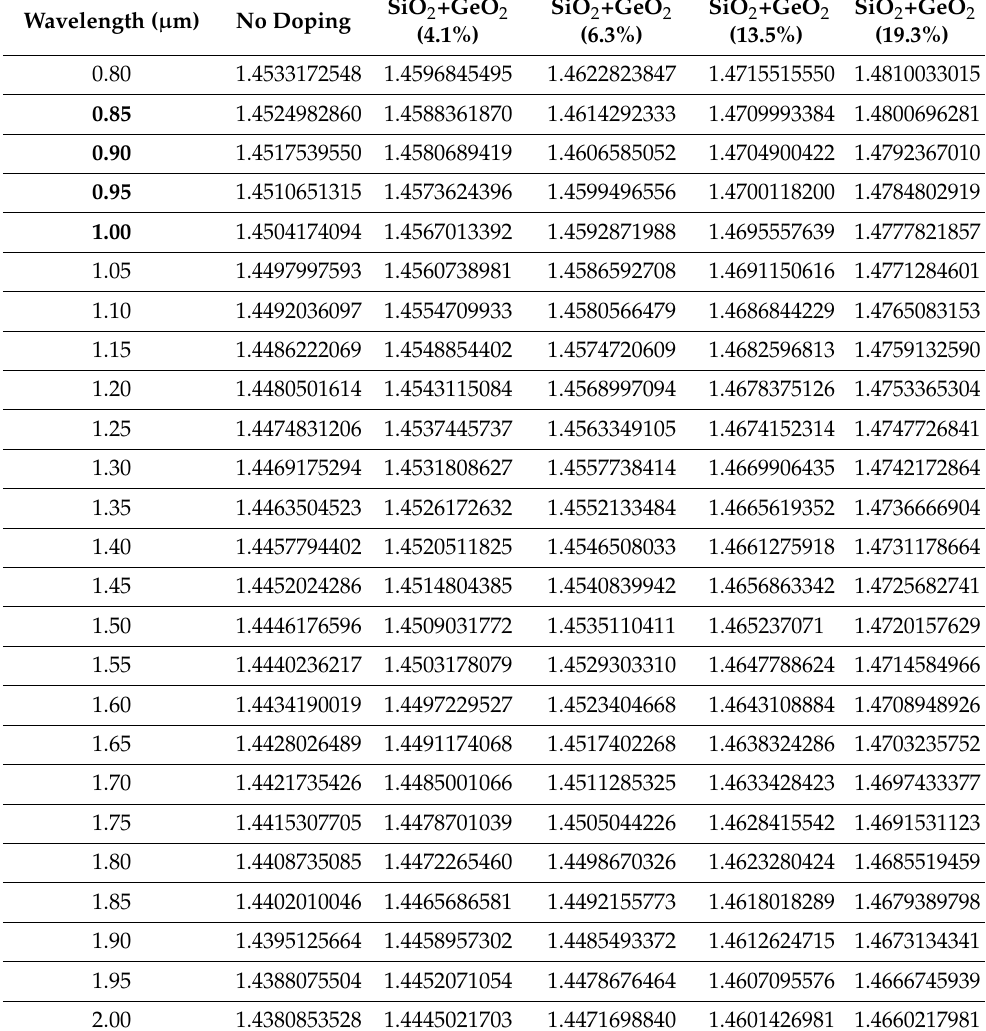
Table 2. RI values obtained for different GeO 2